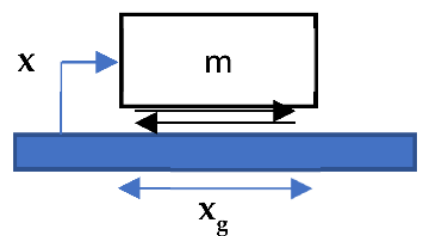
Figure 19. Slip model and equation of motion for simulation of the ruptured LRB.